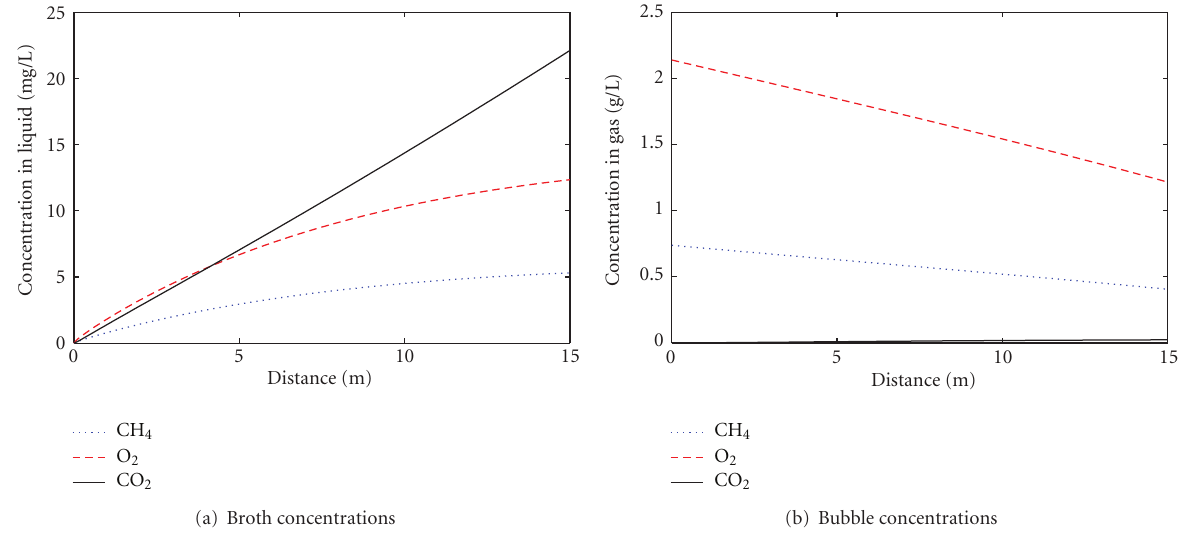
Figure 4: Startup concentration profiles in the liquid and gas phases ( P T = 3atm, k L a = 0 . 05s − 1 , C X 0 = 5g/L, G/L = 0.20, and U L = 0 . 5